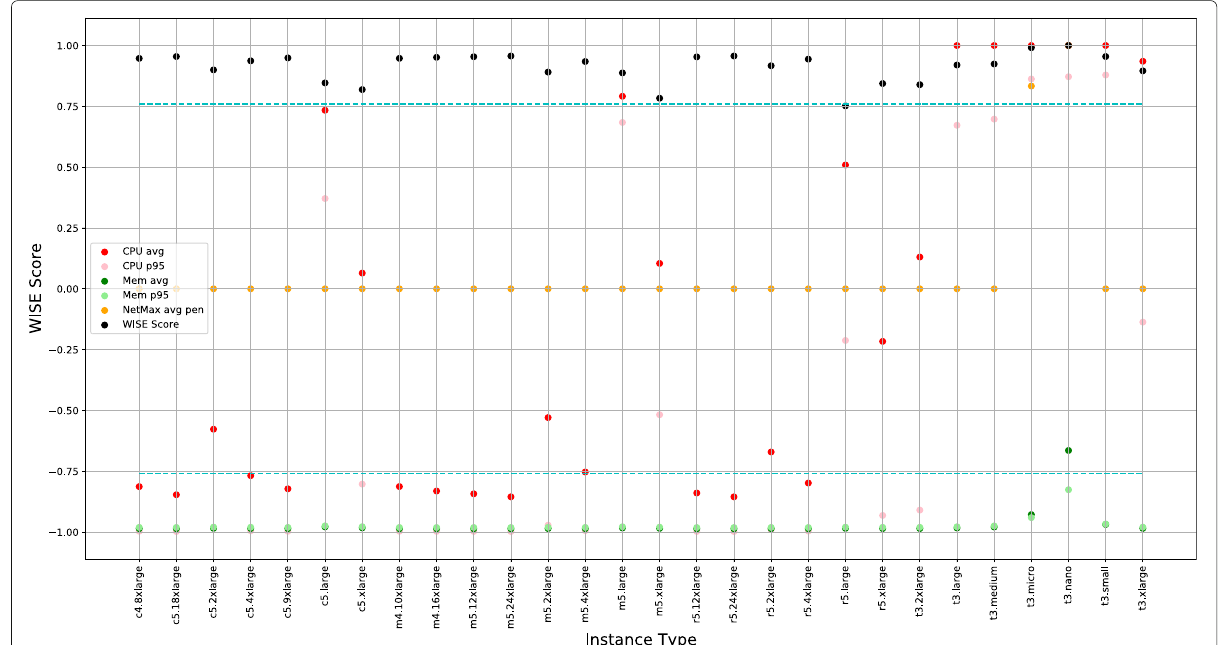
range. As average network utilization has only an upper limit (penalty), it will only affect the machine score when the utilization goes above this limit. The plot displays this by showing a dot on 0 when it has no affect. Figure 9 dis- plays the same data as in Fig. 8, except that the overall